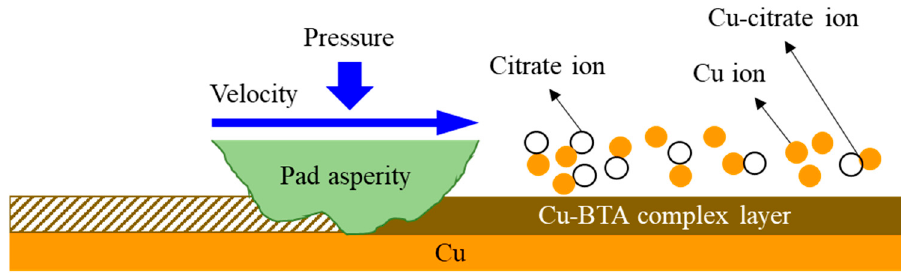
Figure 14. Material removal mechanism of EAF-CMP.